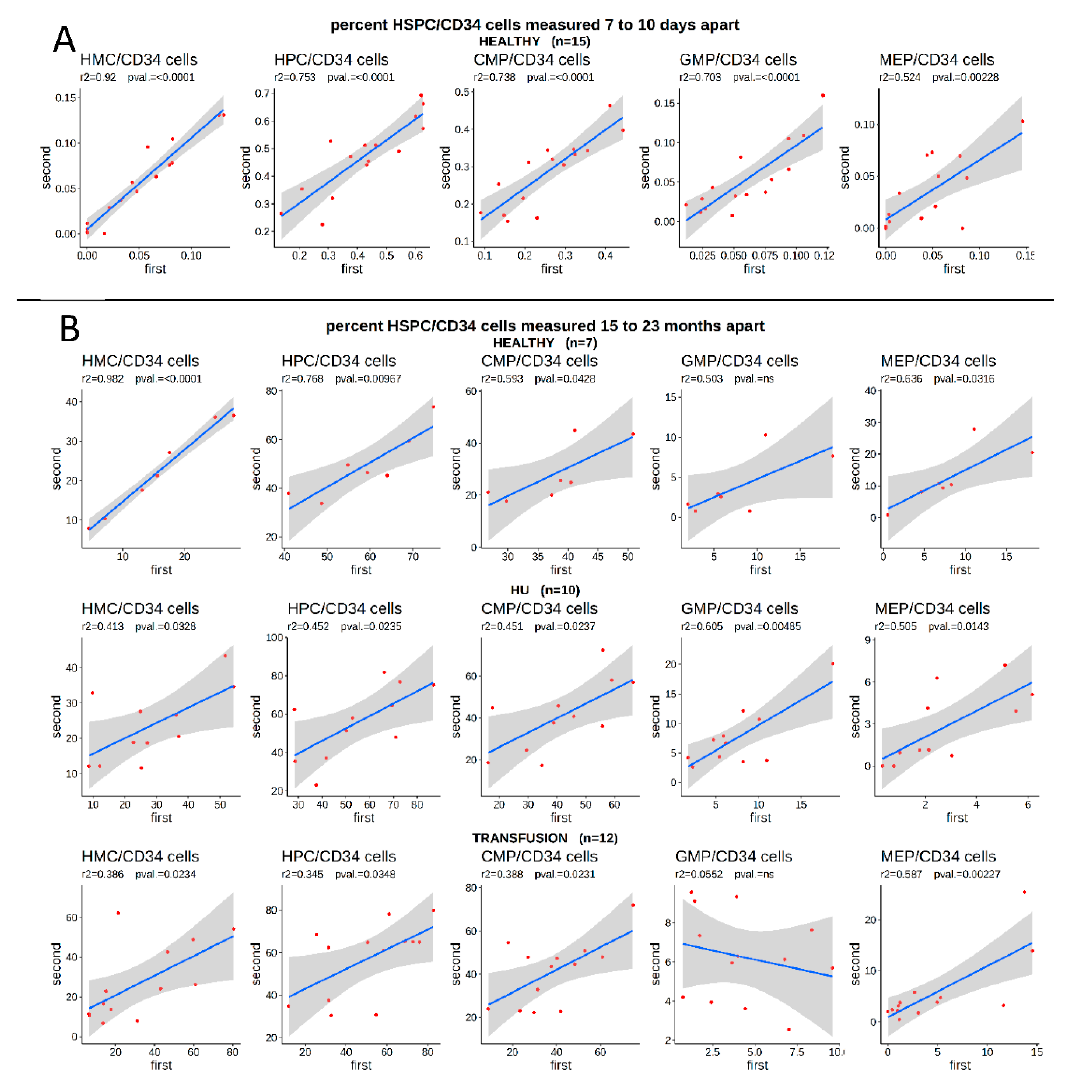
Figure 2. Percentage of circulating HSPC / CD34 bright cells in the blood is stable over time. ( A ) Blood samples were collected from 15 healthy individuals at 7 to 10 day intervals and the percentage of circulating HSPC / CD34 bright cells was measured by FACS. Blue line represents the linear regression; grey smooth area represents the 95% confidence intervals ( r 2 and F-statistic p -values are provided above). The percentage of circulating HSPCs was highly variable between individuals but stable over time within the same individual. X- and y-axis: Percentage of HSPC / CD34 bright cells measured at first and second collection. ( B ) Blood samples were collected from 7 healthy individuals, 10 HU-treated SCD patients, and 12 transfusion-treated SCD patients at 15- to 20-month intervals and the percentage of HSPCs was measured by FACS. The percentage of circulating HSPC / CD34 bright cells was highly variable between individuals, but stable over time in the same individuals, particularly in healthy